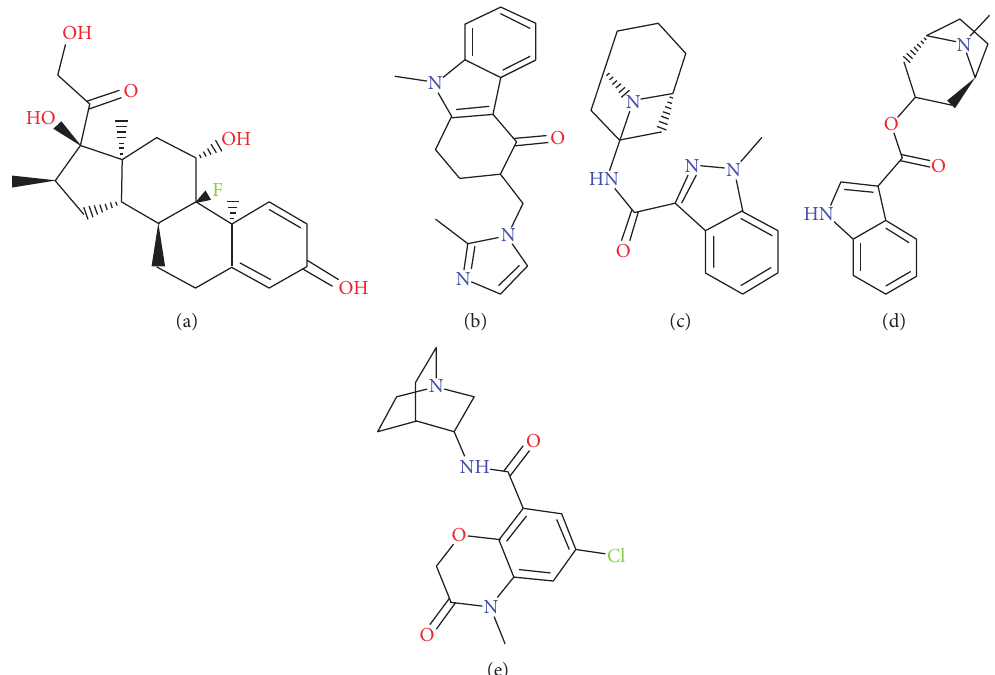
Figure 1: Chemical structure of DEX (a), OND (b), GRA (c), TRO (d), and AZA